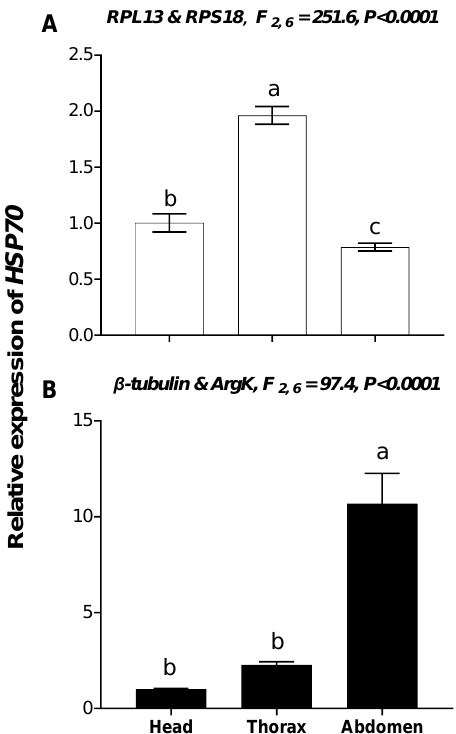
Figure 8. Relative gene expression of HSP70 in different tissues of T. radiata . The relative abundance of HSP70 in the head, thorax and abdomen were normalized to the most stable ( A : RPL13 and RPS18 ) and least stable ( B : β - tubulin and ArgK ) reference genes, respectively. The values are means + SE. Normalized to head. The significant differences are indicated by different letters, e.g., a, b, c ( p < 0.05).